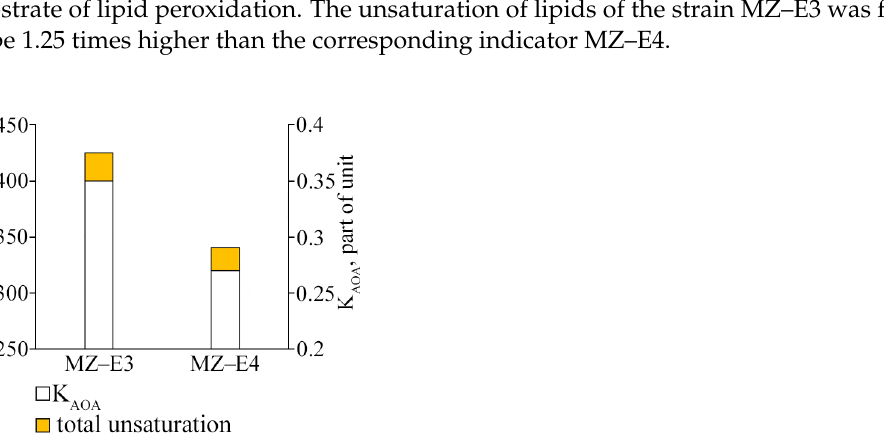
Figure 5. TBA-active products and protein content on the dry residue of protein and cell suspension of Vischeria vischeri strains (MZ–E3; MZ–E4). ( a ) TBAaP. ( b ) TBAaP in . ( c ) Protein. Medium: BBM; culture volume: 250 mL; incubation time: 25 days; M ± S.E., n = 3.